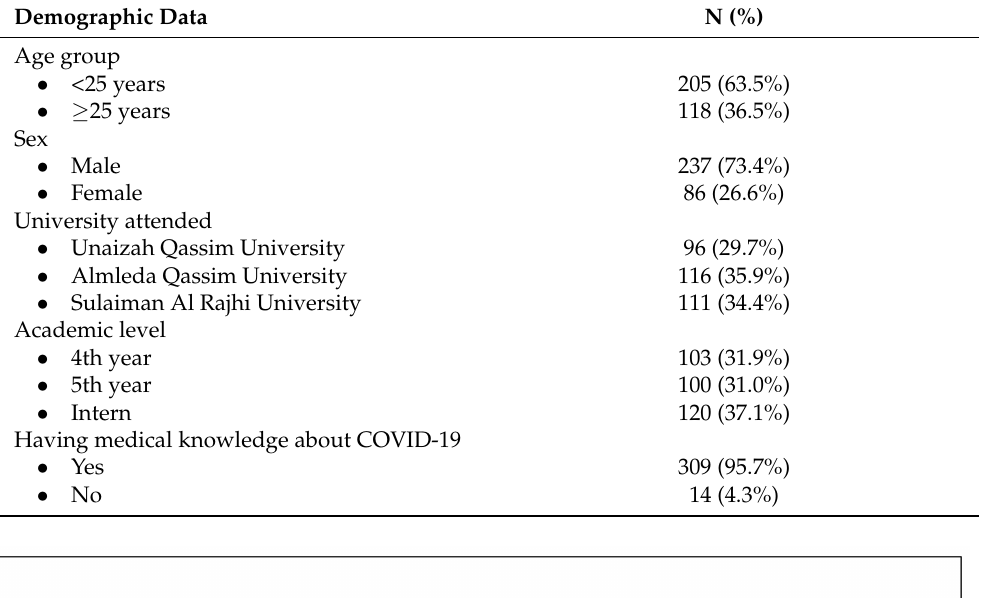
Table 1. Basic demographic data of medical students ( n = 323).